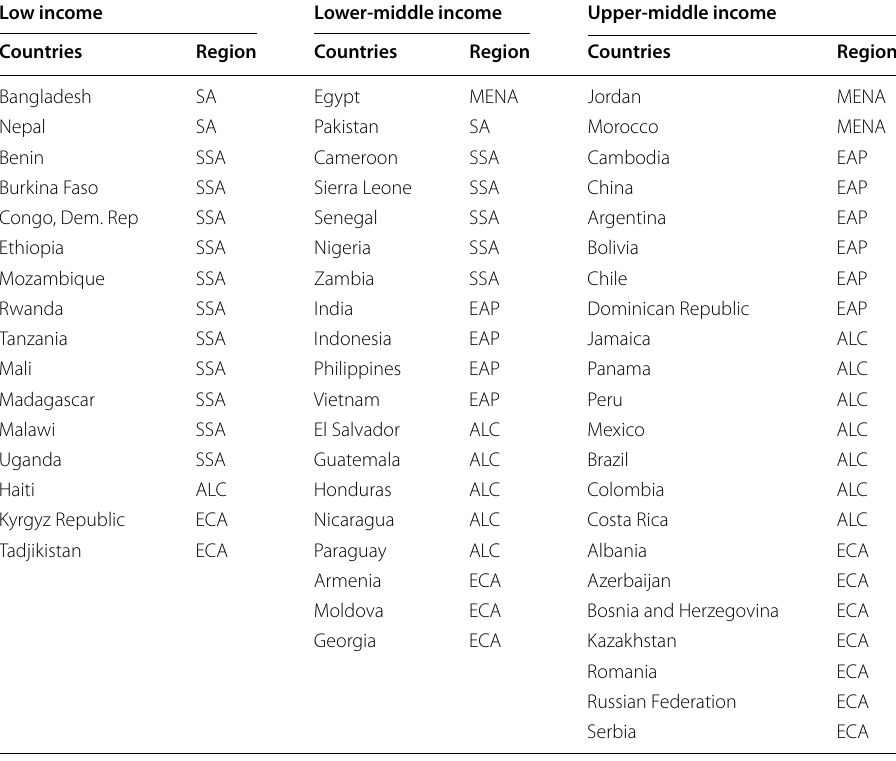
MENA Middle East and North Africa, SA South Asia, SSA Sub‑Saharan Africa; EAP East Asia and Pacific, LAC Latin America and Caribbean, ECA Europe and Central Asia